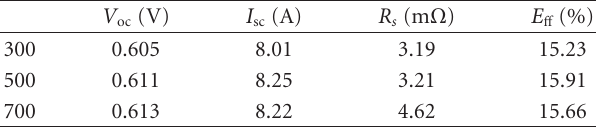
Table 1: The influence of deposition time on the properties of black silicon solar